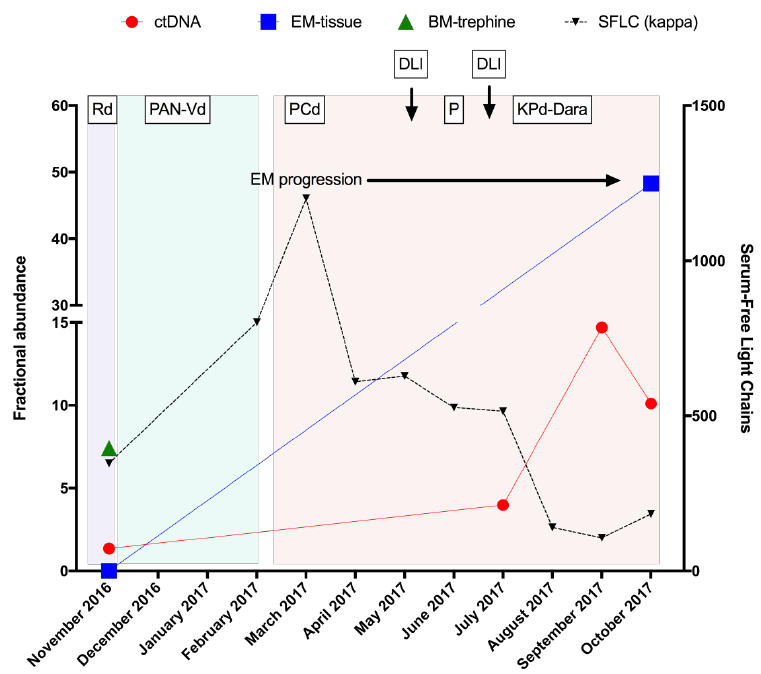
Figure 3. Longitudinal tracking of NRAS Q61H mutation as an evidence for spatial heterogeneity and as a marker of tumour burden. FA of NRAS Q61H in sequential PL, BM-trephine and EM tissues. EM-S obtained in November 2016 did not have any detectable levels of NRAS Q61H, however, this is a dominant clone in EM1/2/3 obtained in November 2017. BM-T collected in November 2016 did demonstrate NRAS Q61H, however, BM disease subsequently responded to treatment but with persisting disease in the EM sites. KLC show an increase until March 2017 and reduction with the introduction of PCd. Single agent P was continued until mid-June 2017 when carfilzomib (K) and daratumamab (dara) were added. The ctDNA levels increase steadily across a period of 12 months, in spite of the decreasing KLC levels.